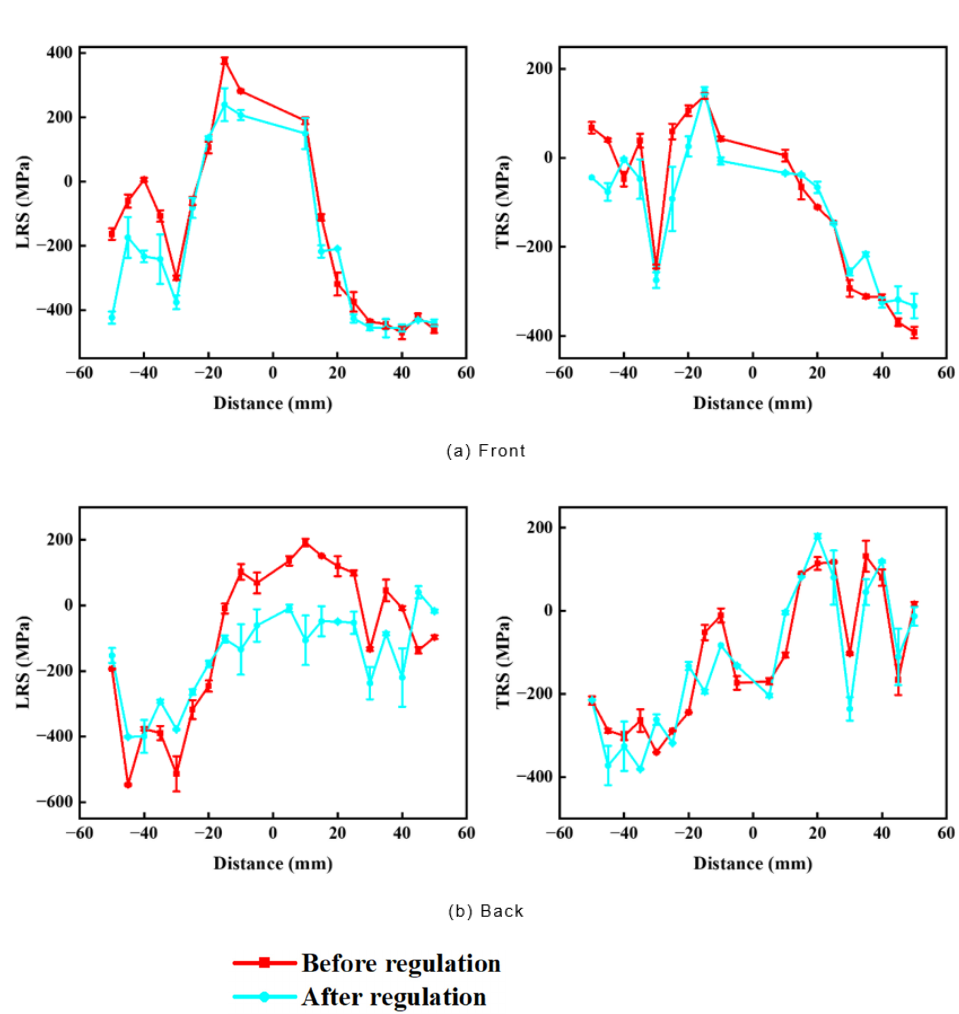
Figure 9. Residual stress distribution of #6 samples before and after treatment. ( a ) Front; ( b ) Back.